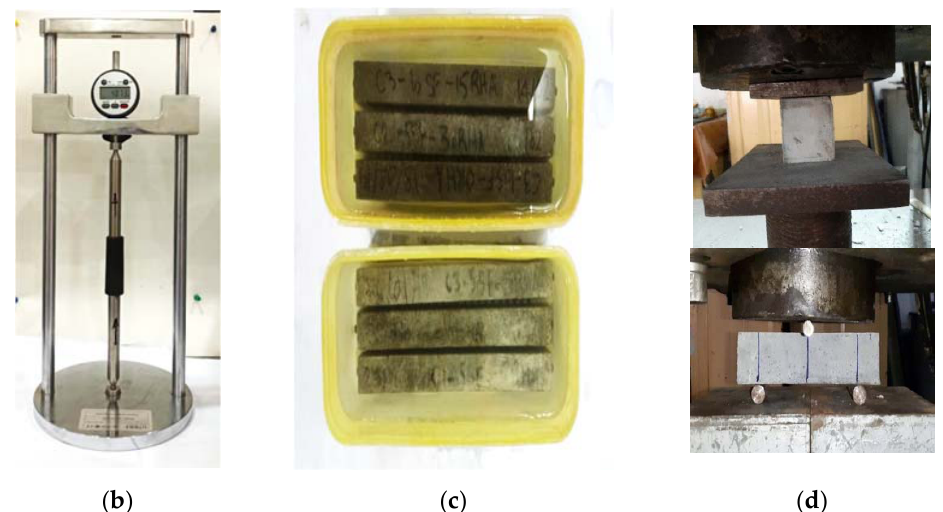
Figure 2. Tested Specimen ( a ) Flow chart of test matrix ( b ) Length Comparator ( c ) Mortar Bar Specimen ( d ) Cube and MOR specimen.